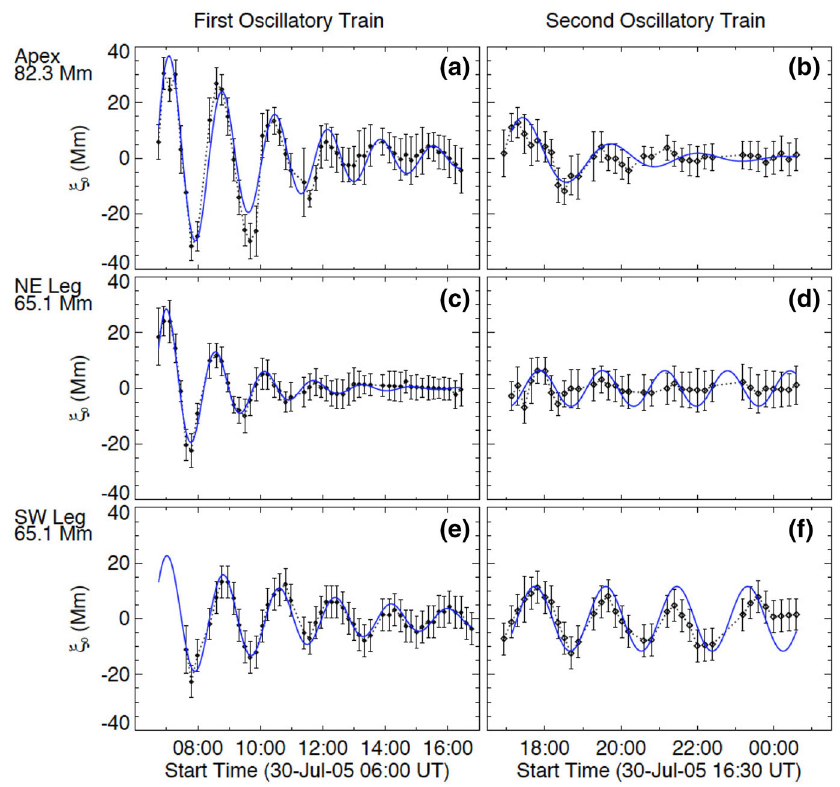
Fig. 2 Displacement versus time produced by two wave trains impacting on a prominence. a , b In the prominence apex, c , d in the NE leg, e , f in the SW leg. Image reproduced with permission from Hershaw et al. (2011), copyright by